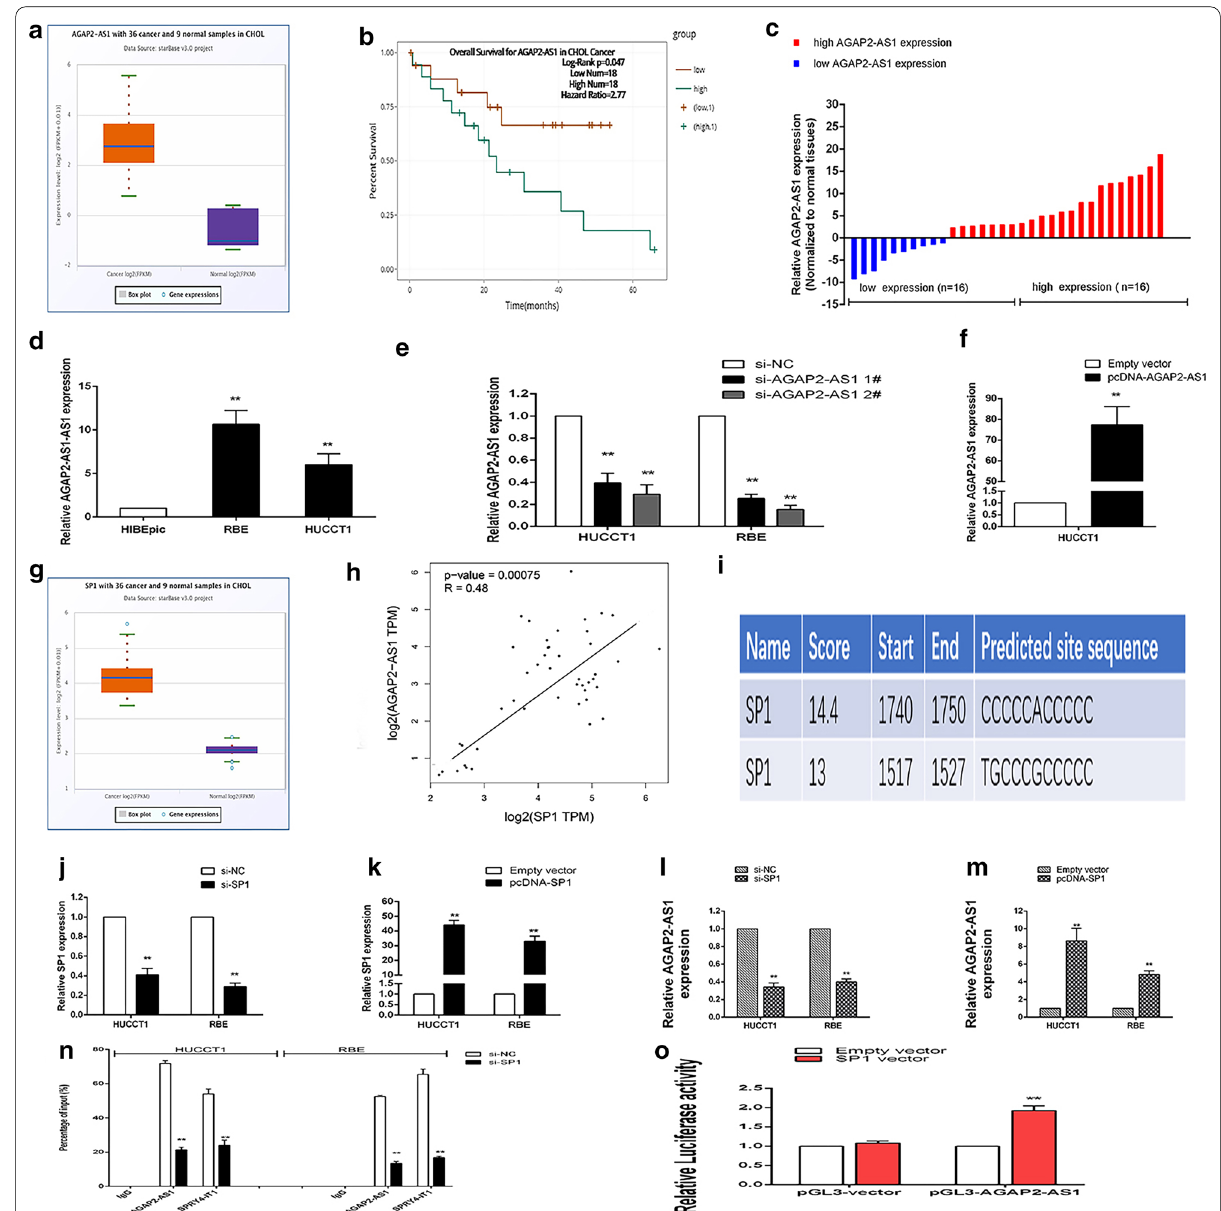
Fig. 1 SP1 induces high AGAP2-AS1 expression in CCA. a , b Relative expression of AGAP2-AS1 in CCA tissues compared with the corresponding adjacent normal tissues (n 32), and classification into two groups. c Kaplan–Meier overall survival curves based on AGAP2-AS1 expression level. d = Analysis of AGAP2-AS1 expression levels in CCA cell lines (HUCCT1 and RBE) by qPCR. e , f qRT-PCR analysis of AGAP2-AS1 expression of HUCCT1 and RBE cells with si-AGAP2-AS1 1, 2, pcDNA-AGAP2-AS1, or the negative control. g JASPR prediction of SP1 binding sites in the AGAP2-AS1 promoter regions. h SP1 knockdown and overexpression efficiency. i Effect of knockdown or overexpression of SP1 on AGAP2-AS1. j CHIP for SP1 in the promoter region of AGAP2-AS1. k Luciferase reporter gene verification. Representative images and data based on three independent experiments. Bars: sd, *P < 0.05, **P < ±